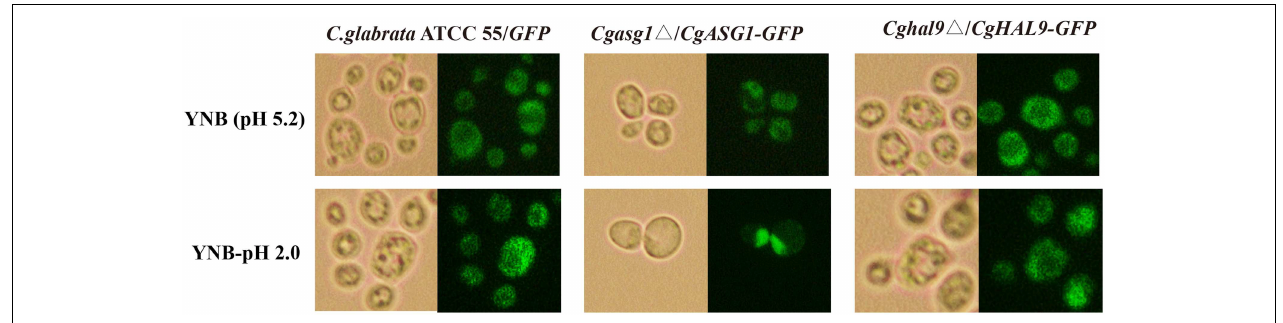
strains, respectively, under the control of the TEF1 promoter. Log-phase cells were treated for 2h in YNB or YNB-pH 2.0 media, and the localization of the GFP fusions was determined by fluorescence